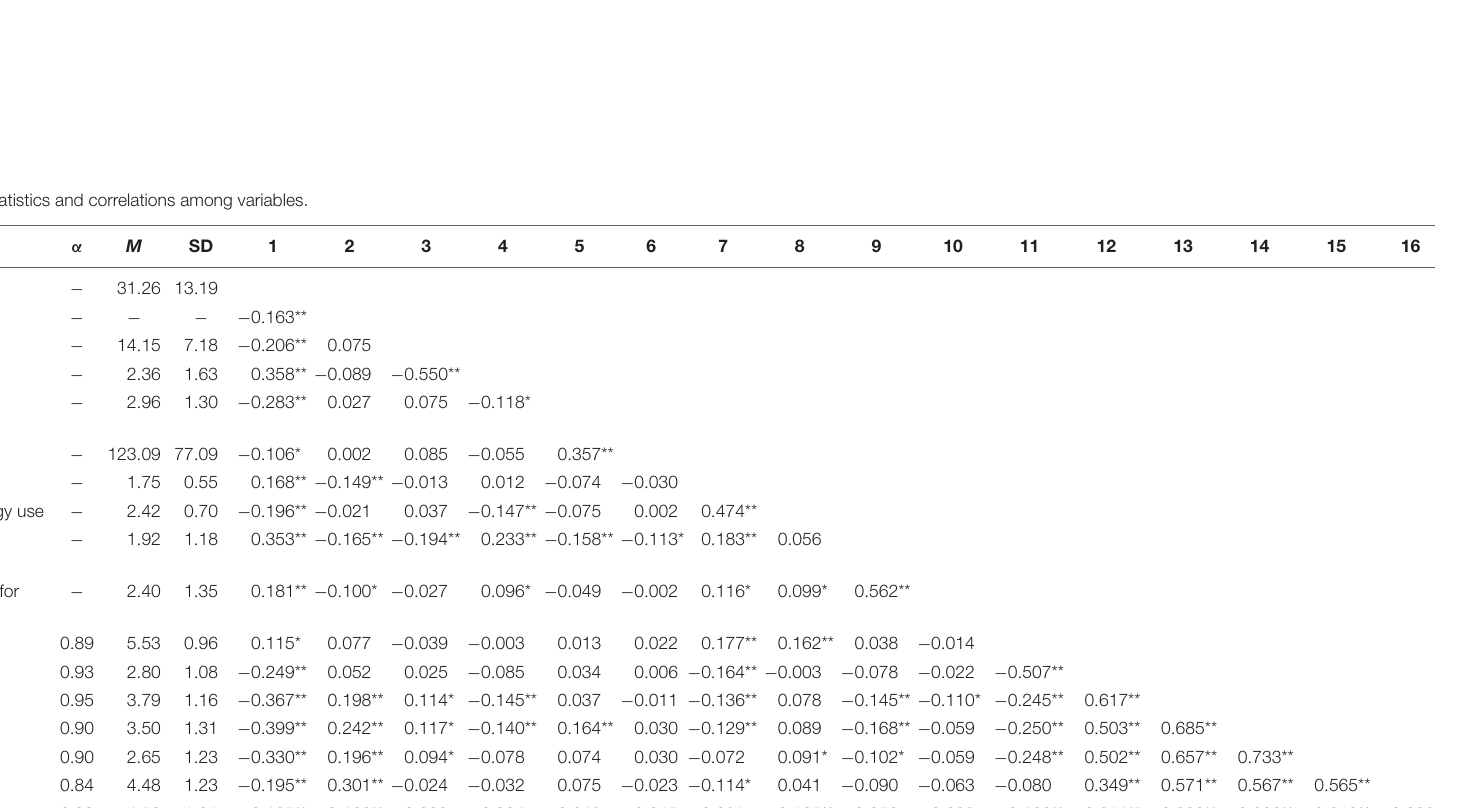
Gender was coded 1 = males and 2 = females. N = 463; *p < 0.05; **p <